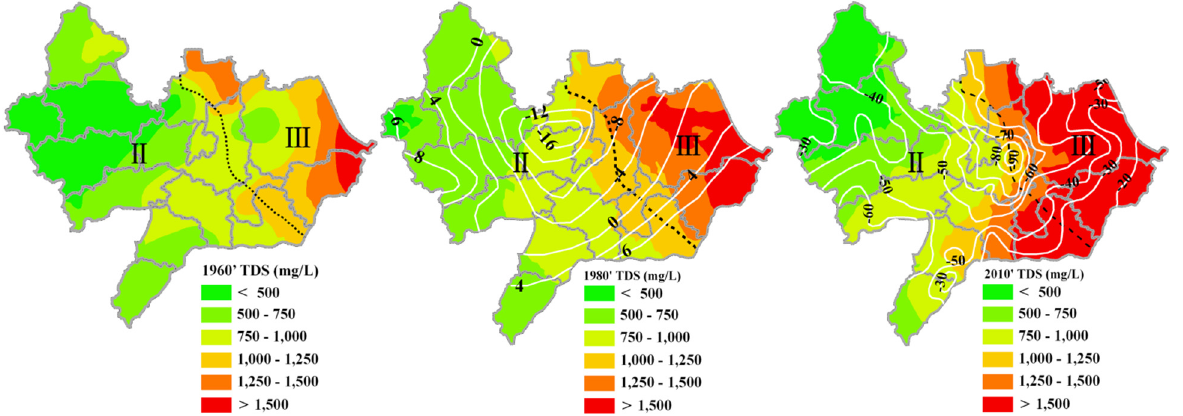
Figure 11. Spatial distribution of TDS concentration in shallow groundwater in the 1980s and 2010s as determined by the COK (white lines in the figures are groundwater levels in 1984 and 2005. Modified from Zhang et al. [35]).